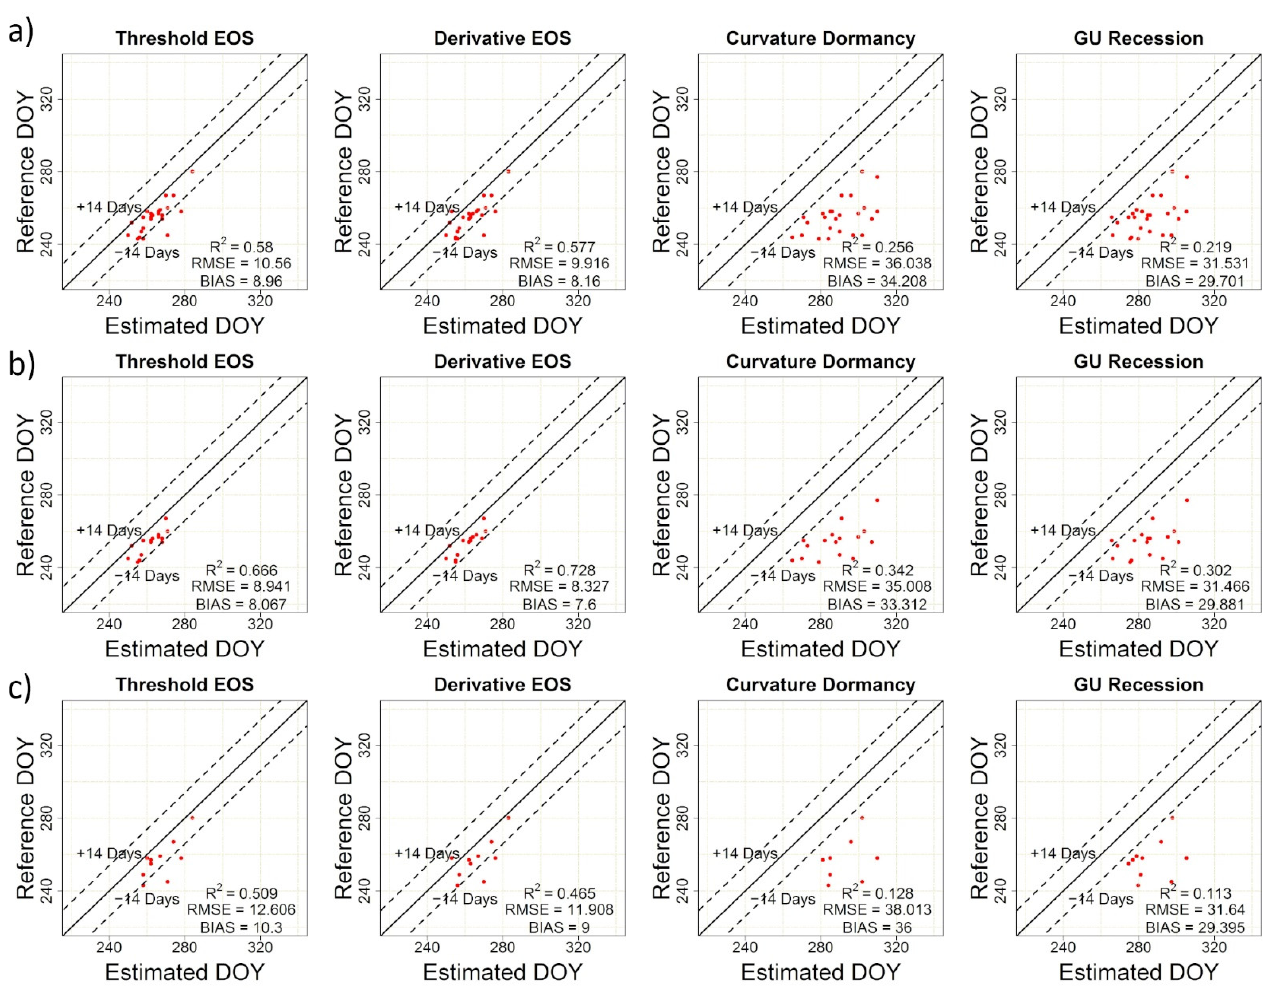
Figure 9. The comparisons between the PlanetScope NDVI-based transition date estimates of the greenness falling period and the visually observed maturity for ( a ) both corn and soybean, ( b ) corn, and ( c ) soybean, using the four phenophase analysis methods.